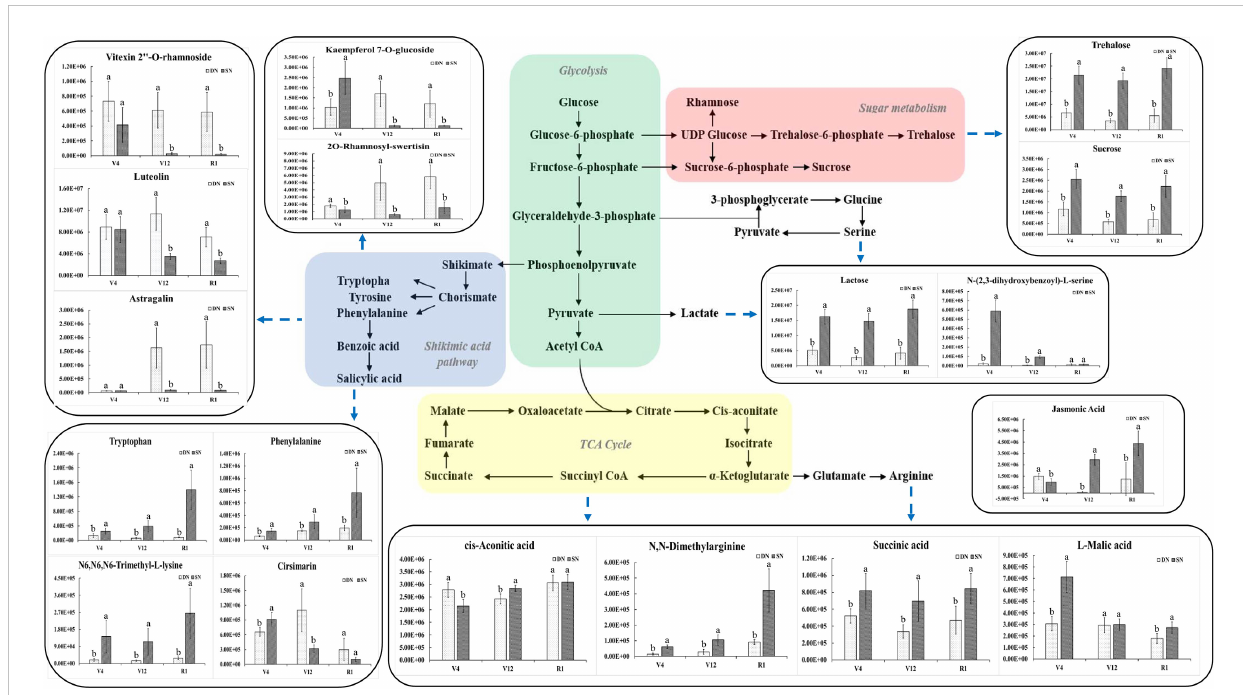
FIGURE 6 Integration of metabolic pathways and metabolic changes caused by nitrogen stress. The substances marked by blue arrows are the metabolites involved in each metabolic pathway. In the histograms, the x-axis represents different growth stages, and the y-axis represents the average values of relative content. Different letters in the same growth period indicate statistically signi fi cant differences at p value <